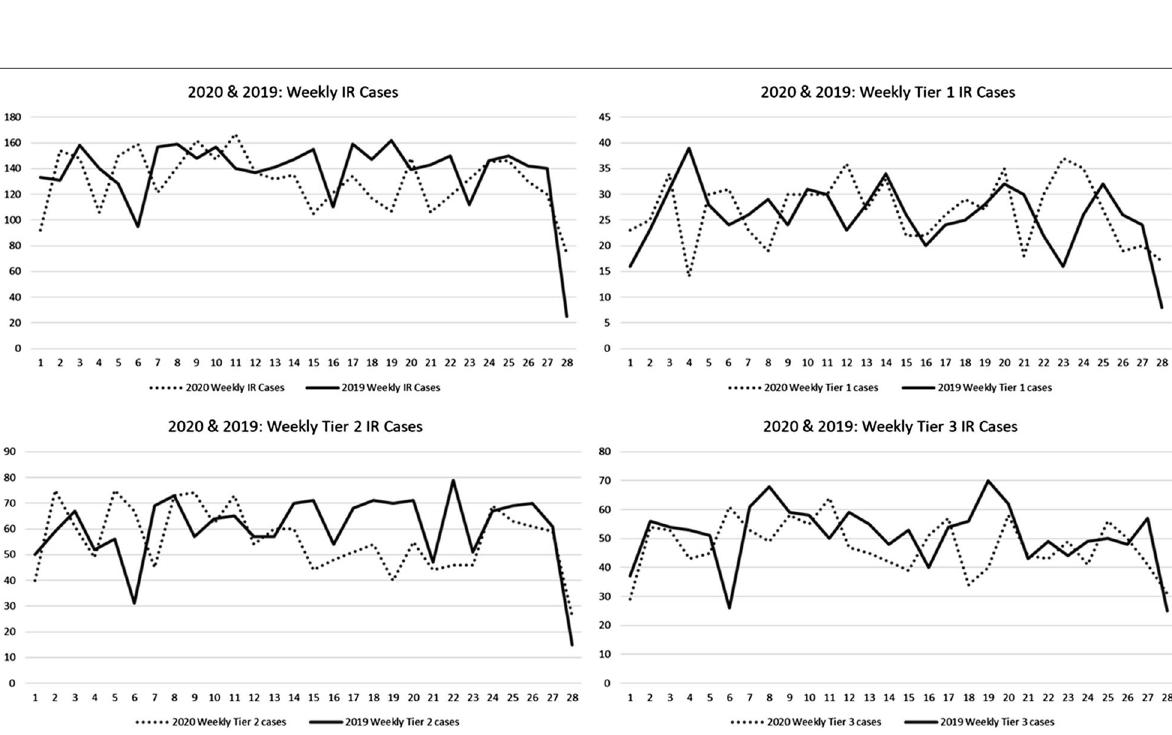
Fig. 3 2020 and 2019: weekly number of IR procedures based on IR-PAS classification: Graphs illustrating the weekly number of IR procedures performed across all tiers, during the COVID-19 pandemic (2020) and pre-pandemic